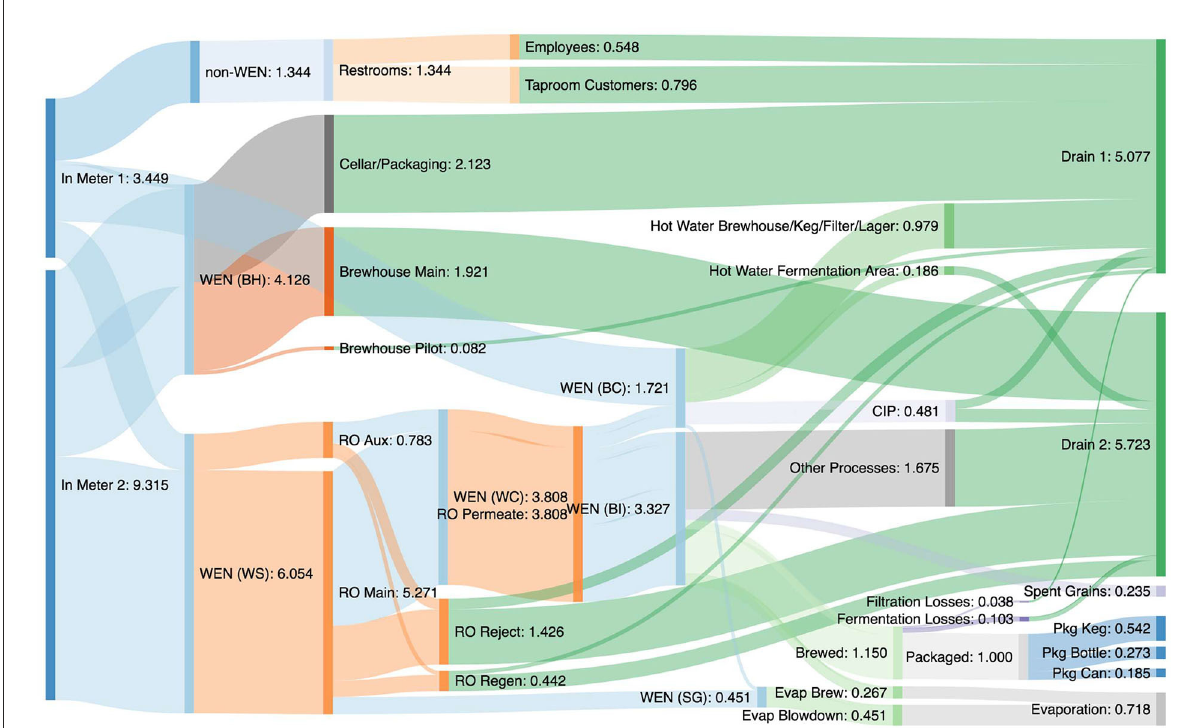
FIGURE3 Sankey diagram showing source and destination of water flows in the brewery [WEN points are included by their abbreviation (see Table 1) to help visualize their interconnectedness. The width of each stream is proportional to its contribution to specific water consumption in bbl/bbl packaged for the first 6 months of 2018. Flows are identified and quantified using a combination of submetering, equipment operational parameters, measurements, and estimates. Some water use could not be fully accounted for and was placed into the unknown category “Other Processes.” Water enters the facility at the left and exits at the